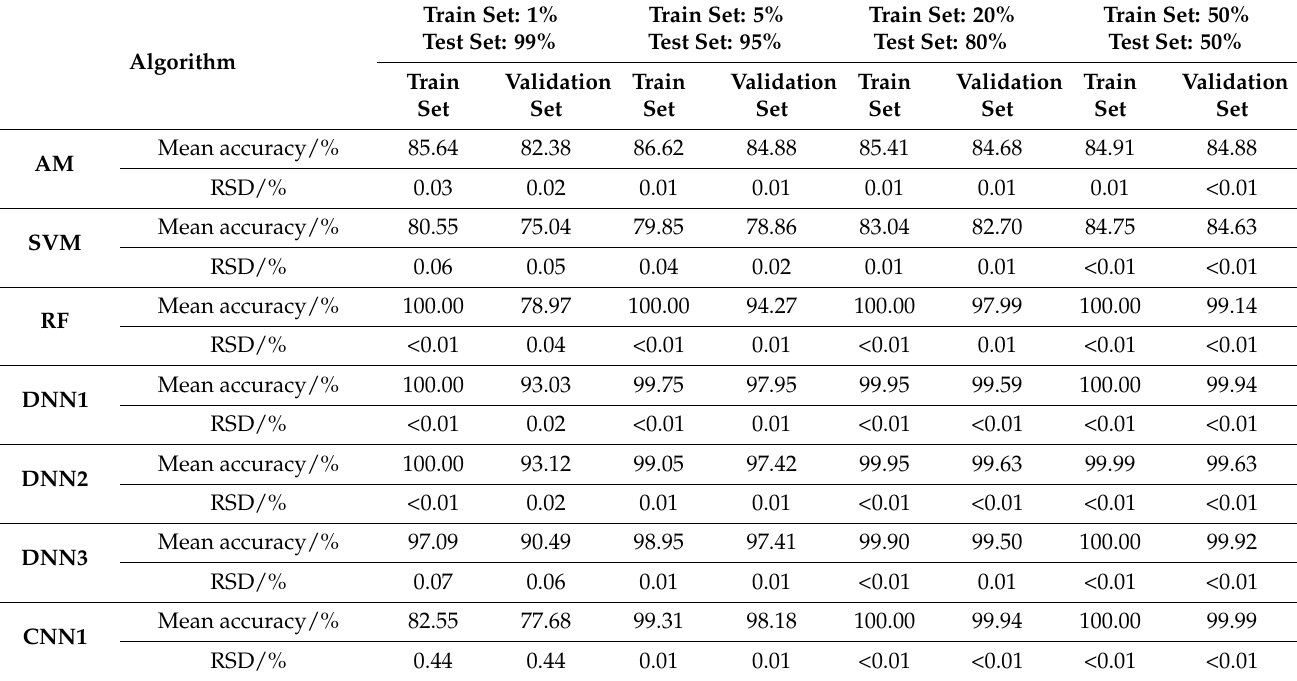
Table 7. Mean and RSD of accuracy using full spectra as inputs and different machine learning algorithms over 10